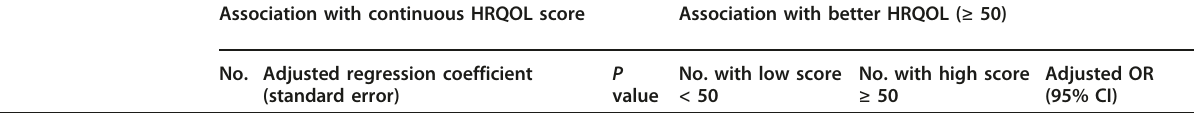
Table 2 The association between estrogenic botanical supplement (EBS) use and health-related quality of life (HRQOL) score Association with continuous HRQOL score Association with better HRQOL ( ≥